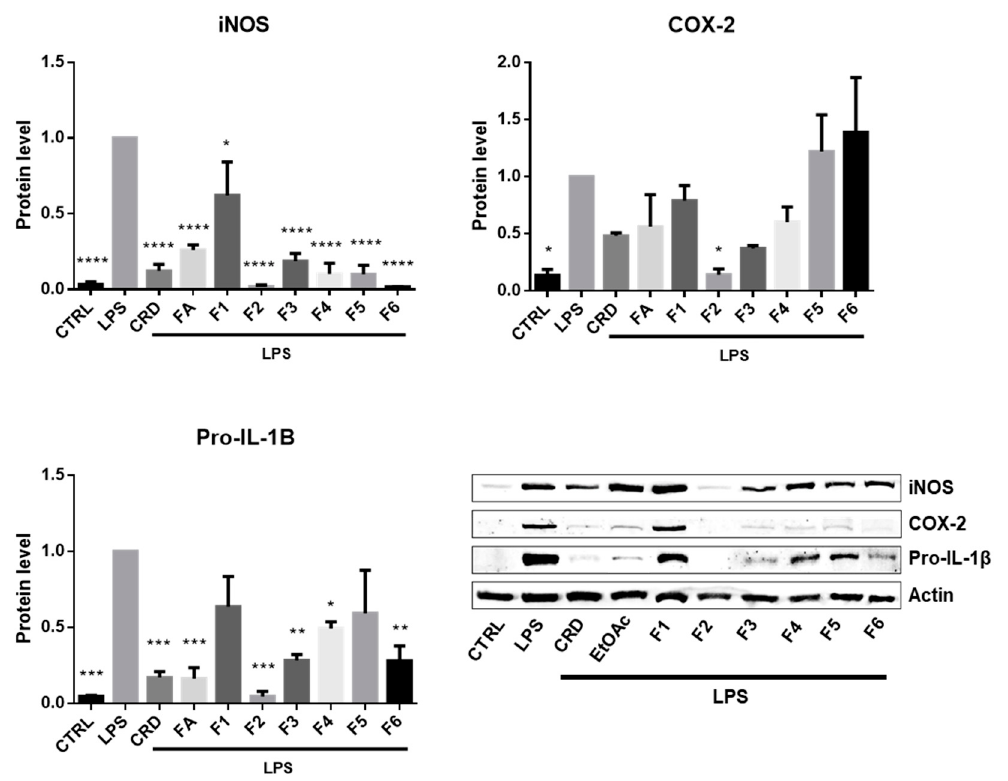
Figure 2. The effects of F. vesiculosus extract and partitioned fractions on the expression of pro IL-1 β , iNOS and COX-2 in LPS-stimulated Raw 264.7 cells. The immunoblots presented are representative of three independent blots; * p < 0.05, ** p < 0.01, *** p < 0.001 and **** p < 0.0001 indicate significant differences from the positive control (LPS), as determined by one-way ANOVA, followed by Dunnett’s post hoc test. CRD—crude extract, EtOAc—ethyl acetate fraction .